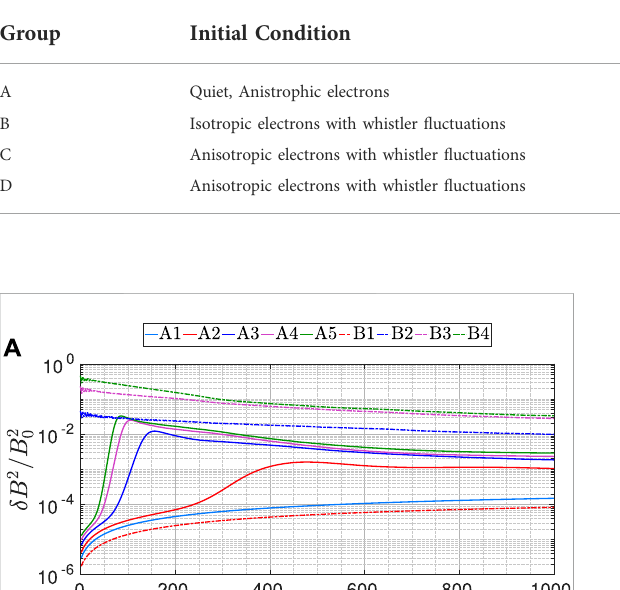
TABLE 1 Summary of simulation cases. In all cases, β e = 0.1 and v te / c = 0.1.